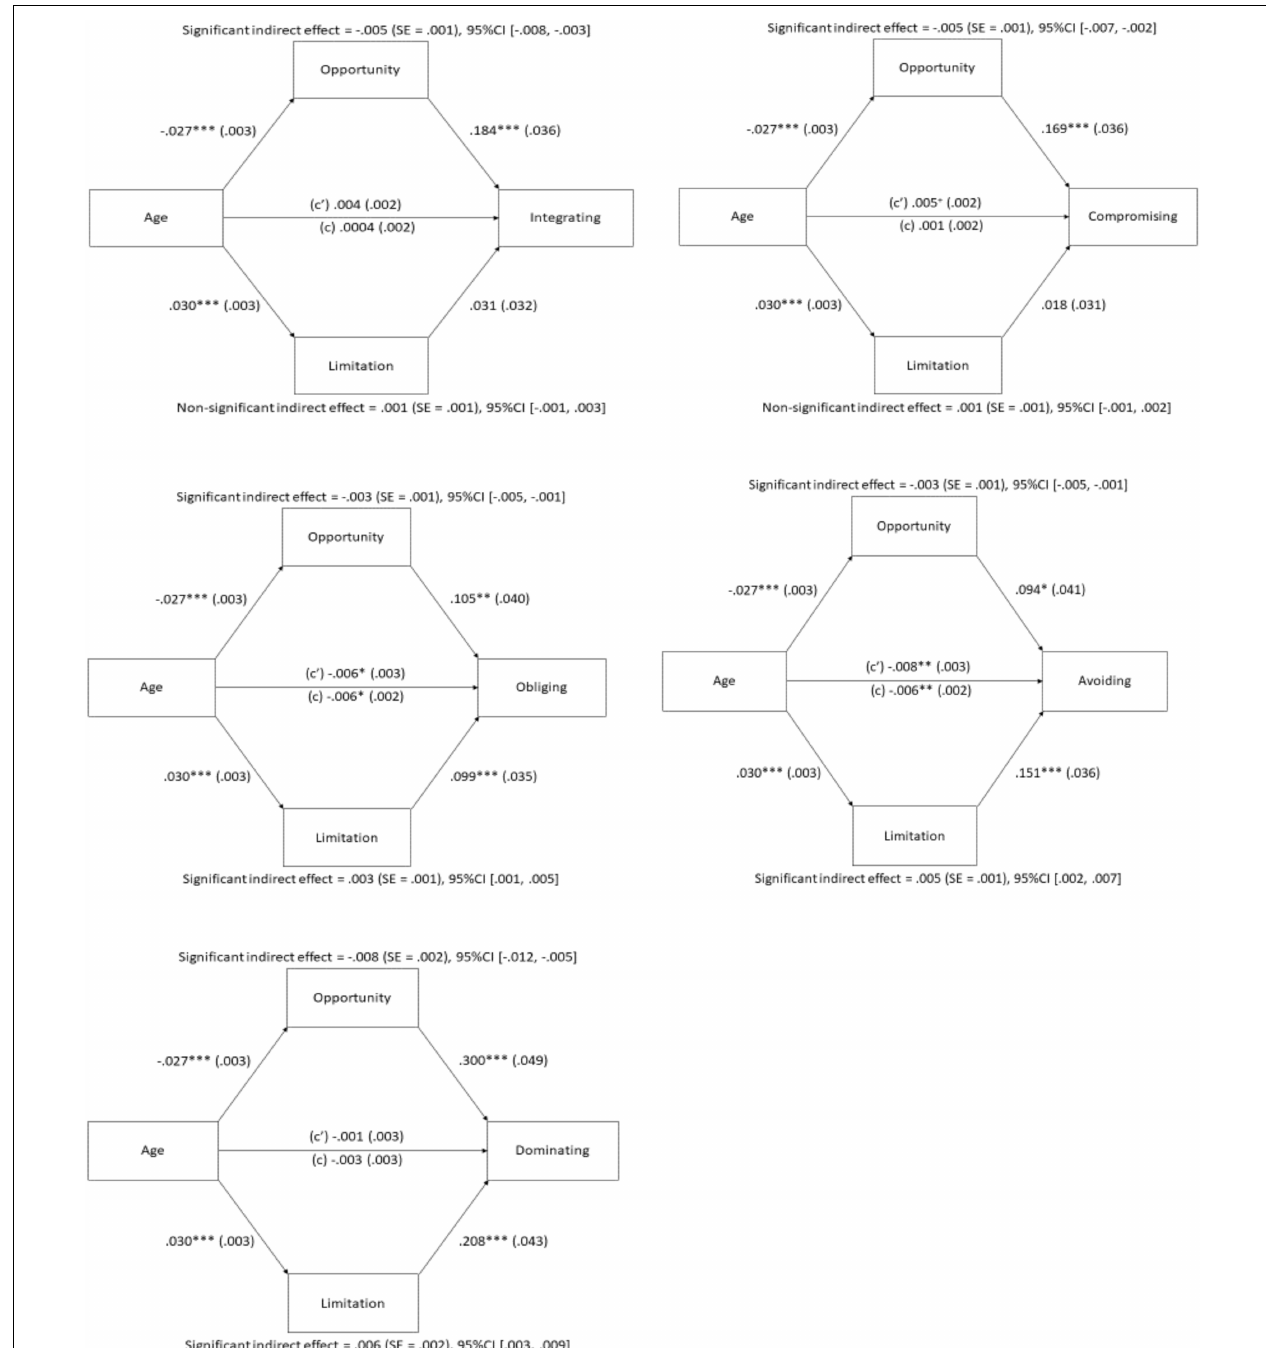
FIGURE 1 | The mediating effects of focus on opportunities and focus on limitations on the five conflict management strategies measured in Study 1. c’ = direct effect. c = total effect. Opportunity = Focus on opportunities. Limitation = Focus on limitations. ∗ p < 0.05; ∗∗ p < 0.01; ∗∗∗ p < 0.001; + p = 0.051.